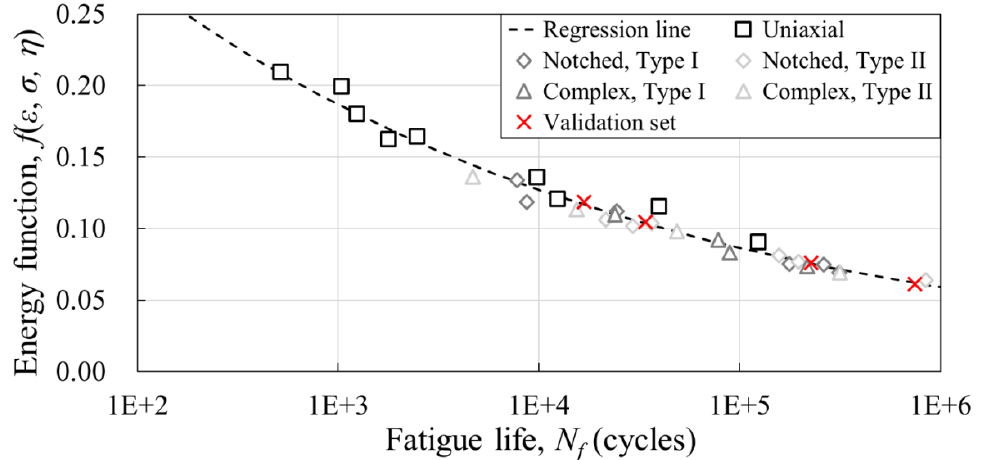
Figure 18. Energy function vs. fatigue life graph with regression line of the PP-CF (log-linear